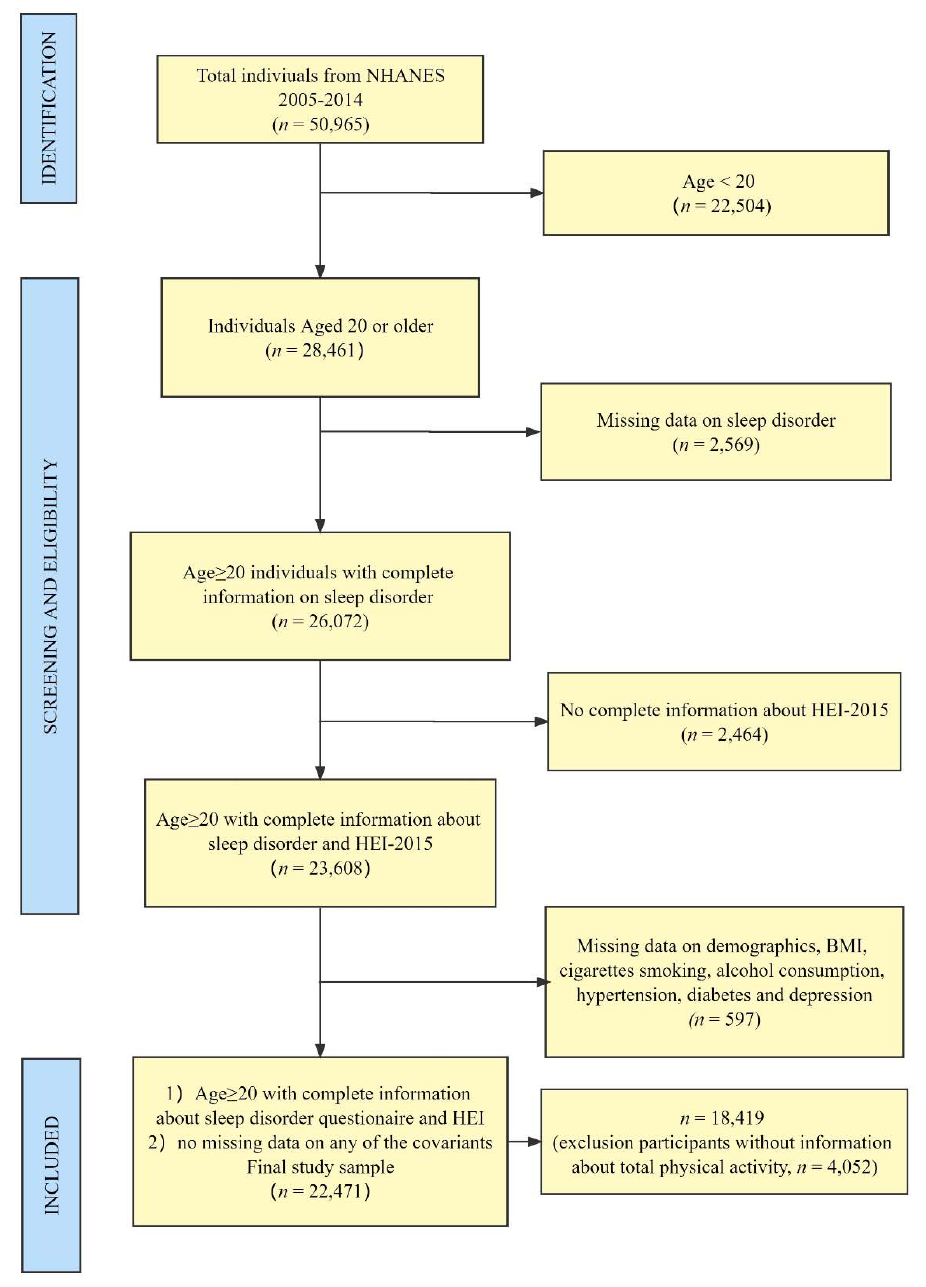
Figure 1. Flowchart of the population included in our final analysis.